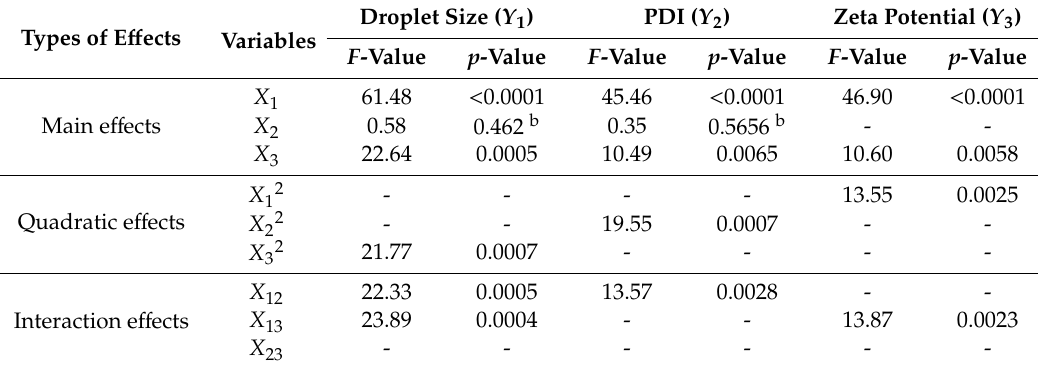
Table 5. The significance probability ( p -value, F -value) of regression coe ffi cients in the final reduced